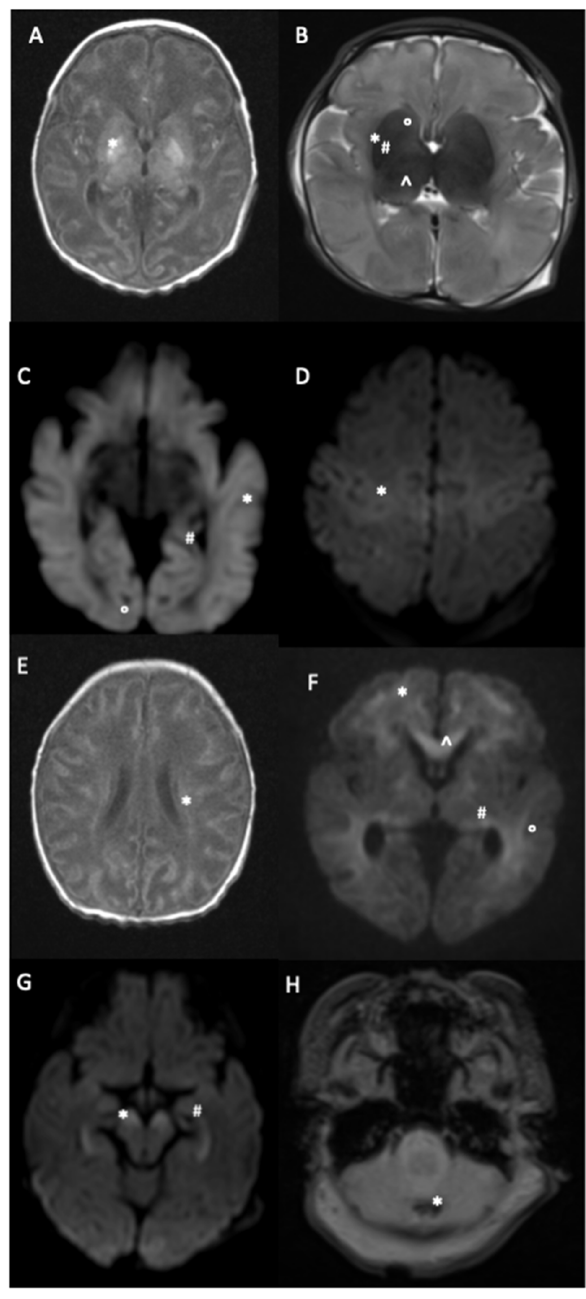
Figure 2. MRI brain injuries in context of neonatal encephalopathy. ( A ) = Axial T1 weighted image (T1W): high signal intensity (SI) of the diffuse cortex and the bilateral basal ganglia involving the globus pallidus (*). ( B ) = Axial 2 weighted image (TW2). Extensive high SI of the white matter and heterogeneous SI of the basal ganglia involving the caudate nucleus (°), putamen (*), globus pallidus (#), and thalamus (^). ( C ) = Diffusion weighted image (DWI): extensive restriction diffusion of the white matter and cortex including the external temporal (*), internal temporal (#) and occipital (°) lobes. ( D ) = DWI: bilateral restriction diffusion of the Rolandic sulci (*). ( E ) = Axial T1W: diffuse high SI of the cortex and centrum semi ovale. (*) ( F ) = DWI: diffuse SI of the anterior watershed region (*) the parietal white matter (°), the PLIC (#) and corpus callosum (^). ( G ) = DWI: restriction signal of the peduncular brain stem (*) and the hippocampus (#). ( H ) = T2W gradient echo: punctiform cerebellum injury in low SI (*).